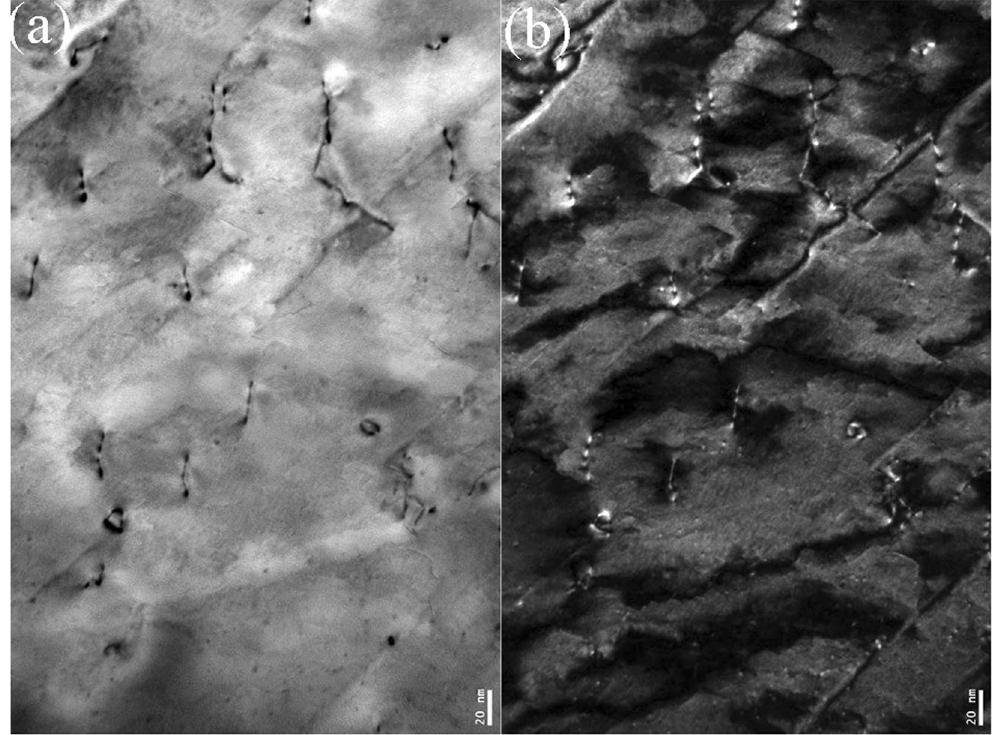
Figure 8. TEM images of dislocations and dislocation loops including ( a ) bright field and ( b ) dark